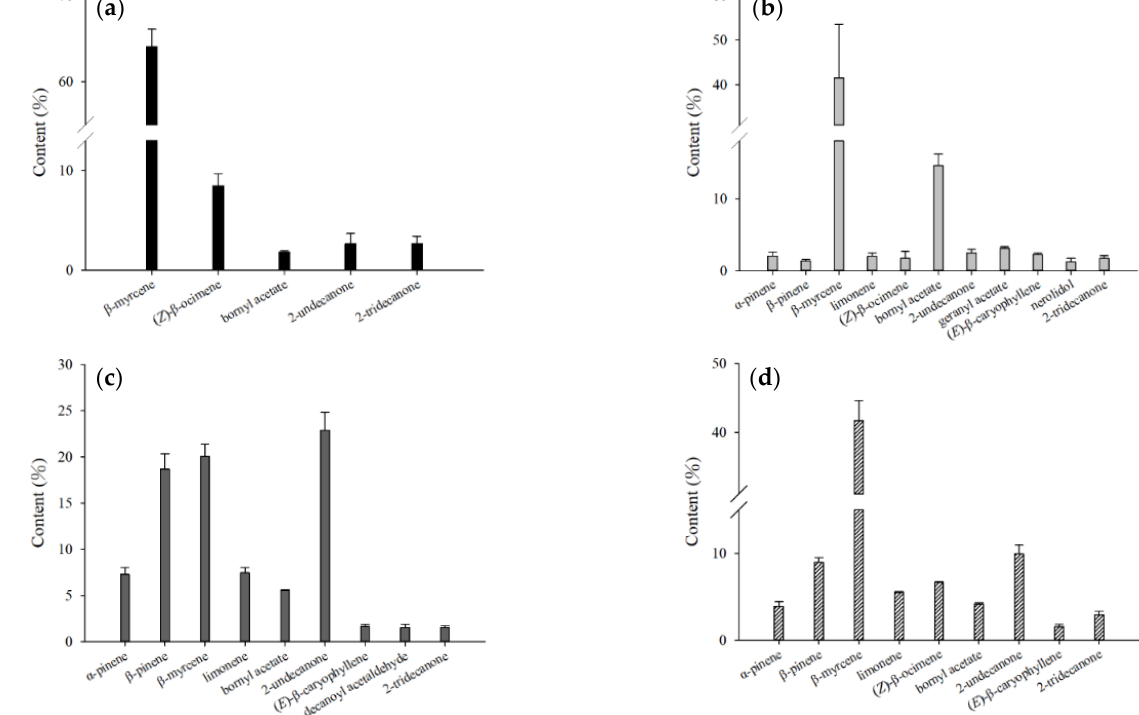
Figure 6. Comparison of the contents of the major volatile compounds in essential oil from different parts of fresh H. cordata analyzed by direct injection: ( a ) leaf; ( b ) stem; ( c ) rhizome; and ( d ) whole plant.